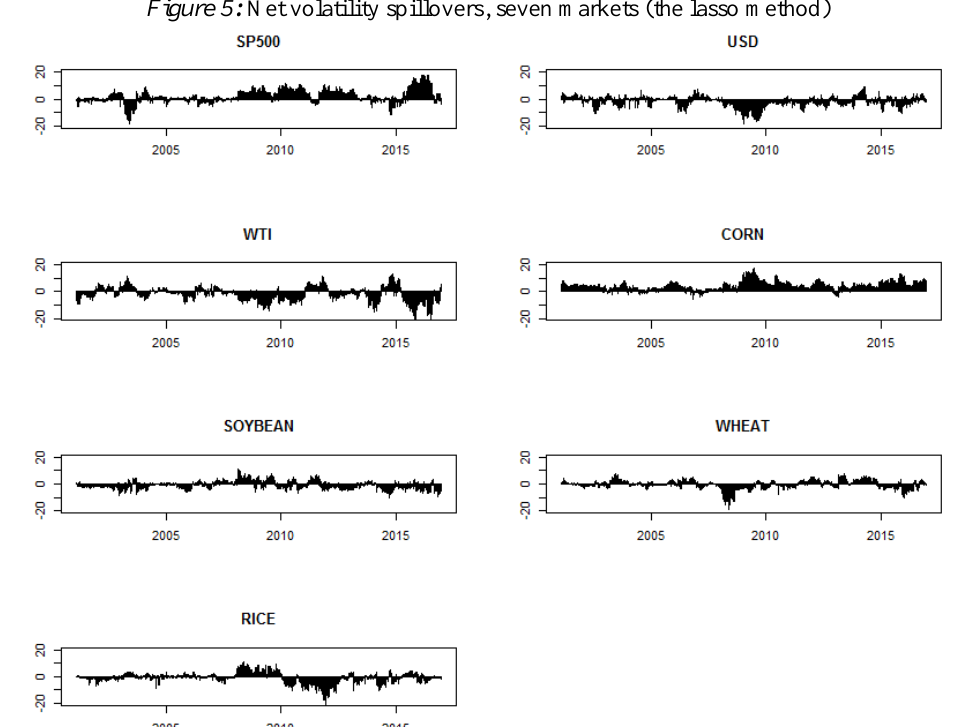
Figure 5: Net volatility spillovers, seven markets (the lasso